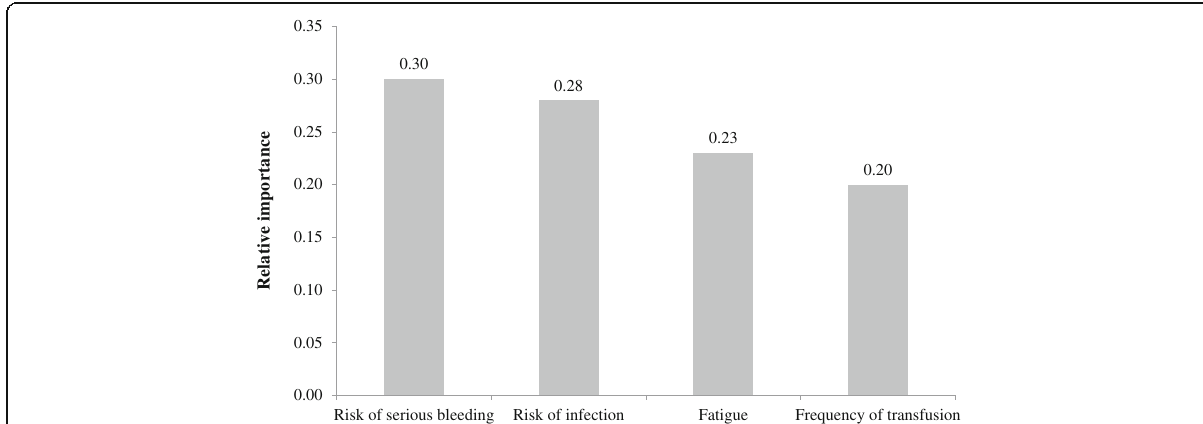
Fig. 2 Relative contribution of each treatment attribute to patient treatment preferences ( N = 30) a . Note: a. The relative contribution of each attribute represents the relative importance each attribute has on treatment preferences. The relative importance of each attribute was calculated as the range of part-worths for the attribute divided by the sum of part-worth ranges for all attributes